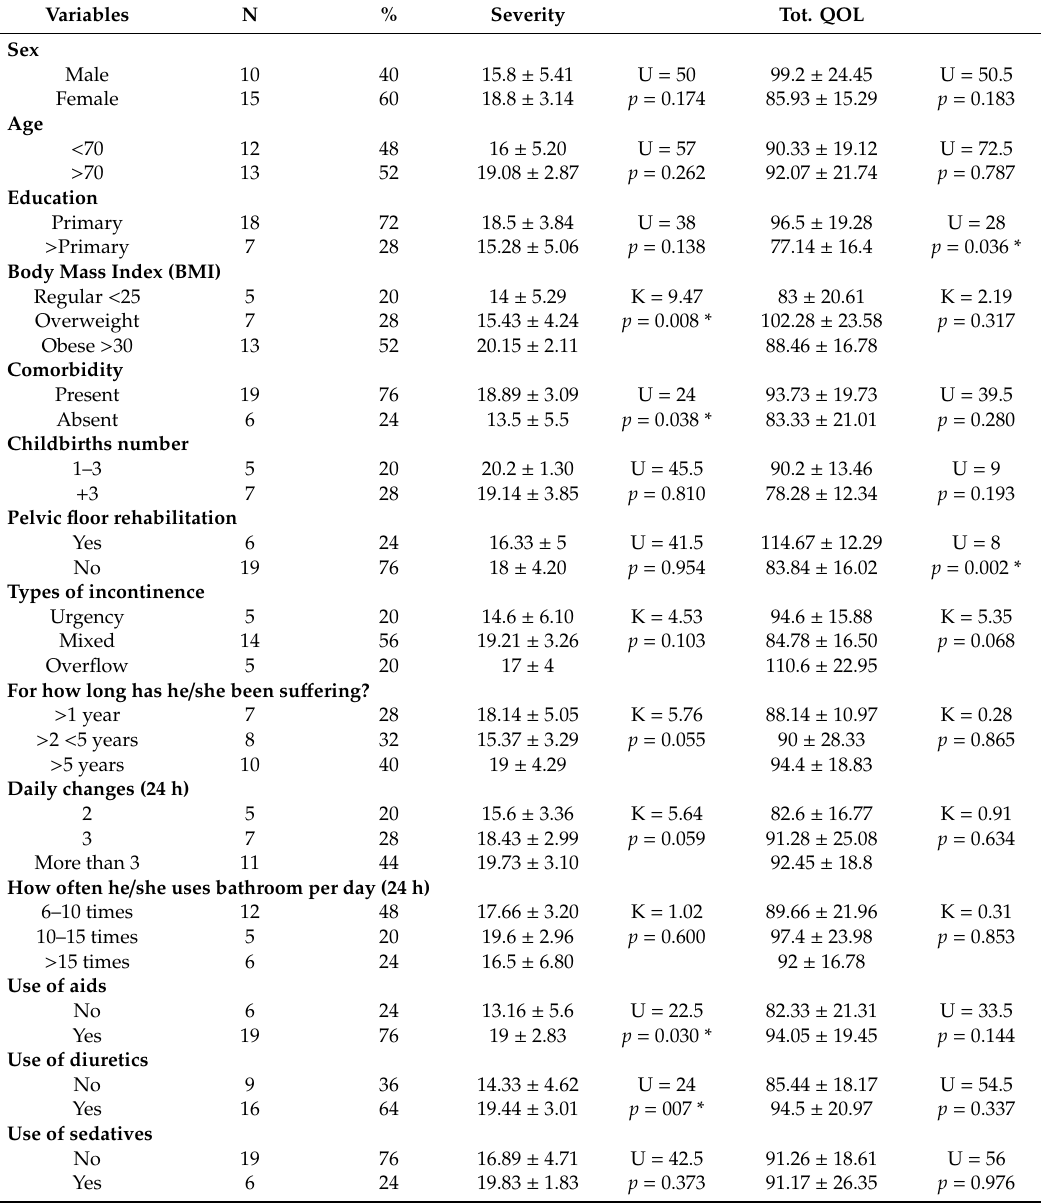
Table 4. This table shows the mean score comparison between severity and total QOL, based on socio-demographic and clinic